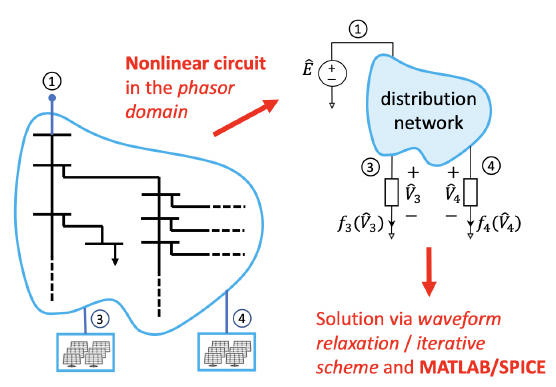
Figure 2. Graphical illustration of the proposed simulation approach for the power-flow analysis